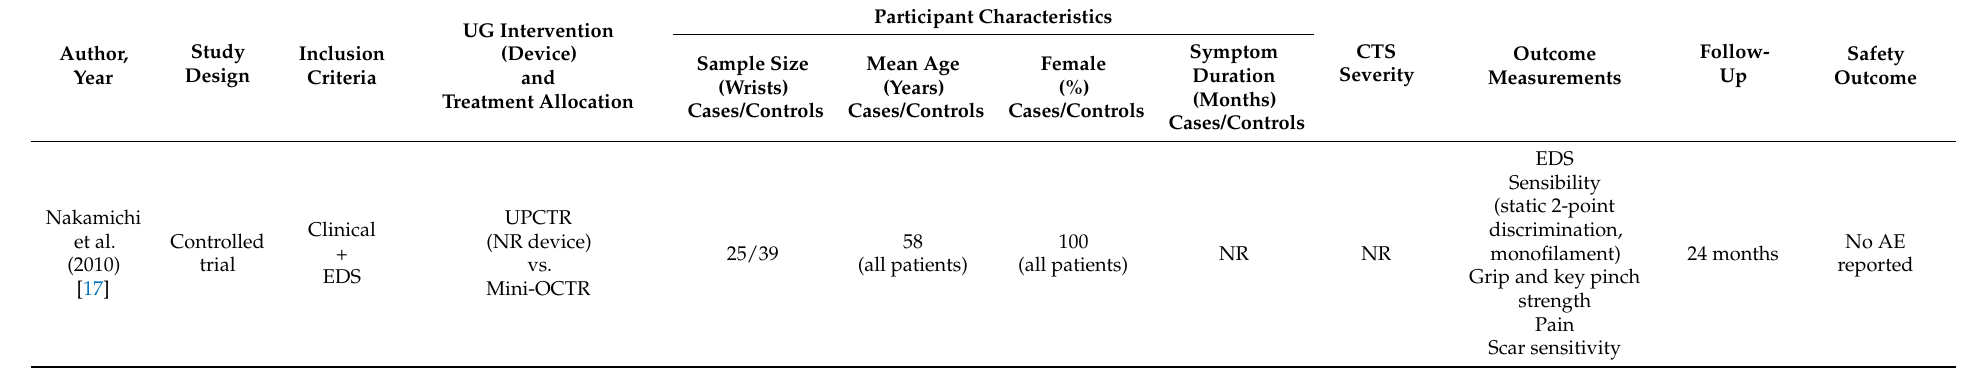
Table 8. Summary of the intervention details in the included studies using ultrasound-guided percutaneous carpal tunnel